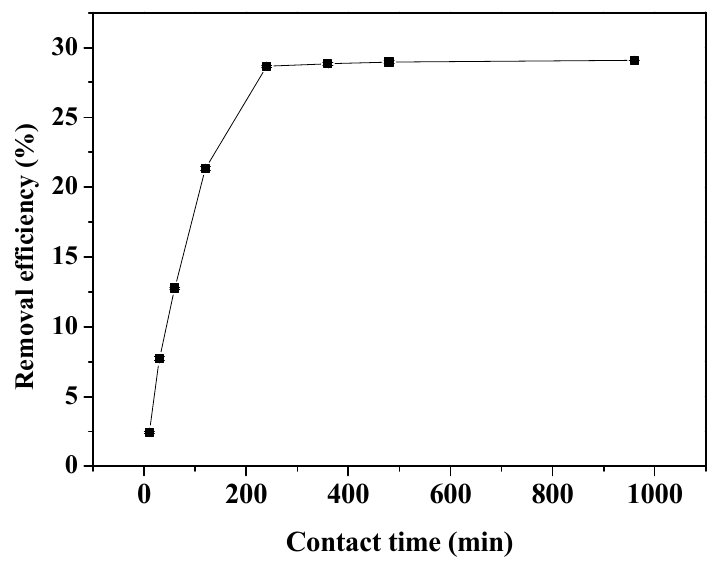
Figure 7. The removal efficiency under the optimal conditions.